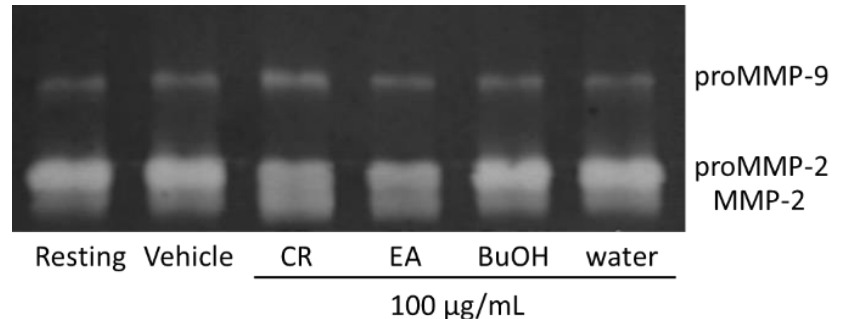
Figure 1. Effects of crude extracts and partitioned parts of A. sinensis leaves on MMP-2 and MMP-9 activity. Results of gelatin zymography. CR, crude extracts; EA, ethyl acetate layer; BuOH, butanol layer; water, water layer.